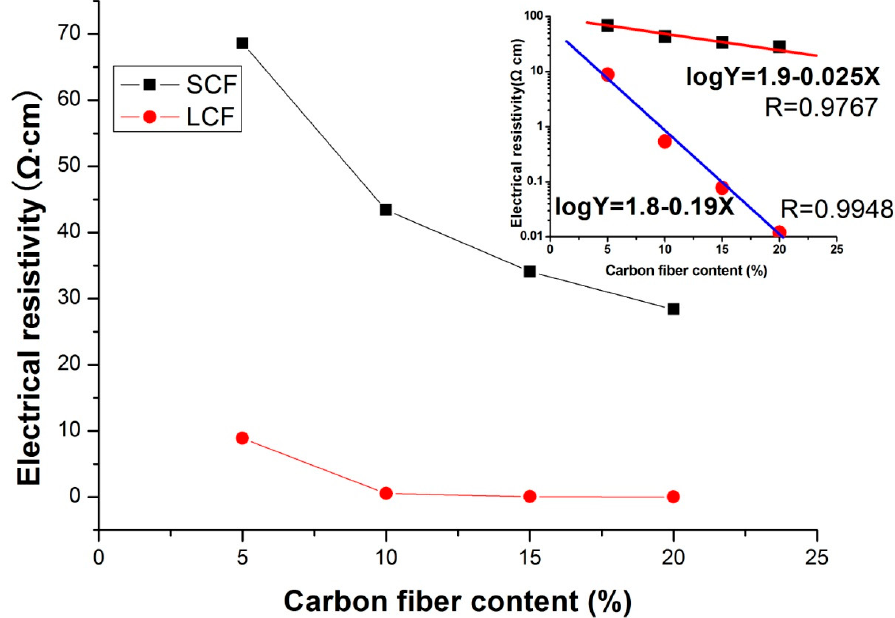
Figure 4. Electrical resistivity for the composite foams as the function of carbon fiber content.